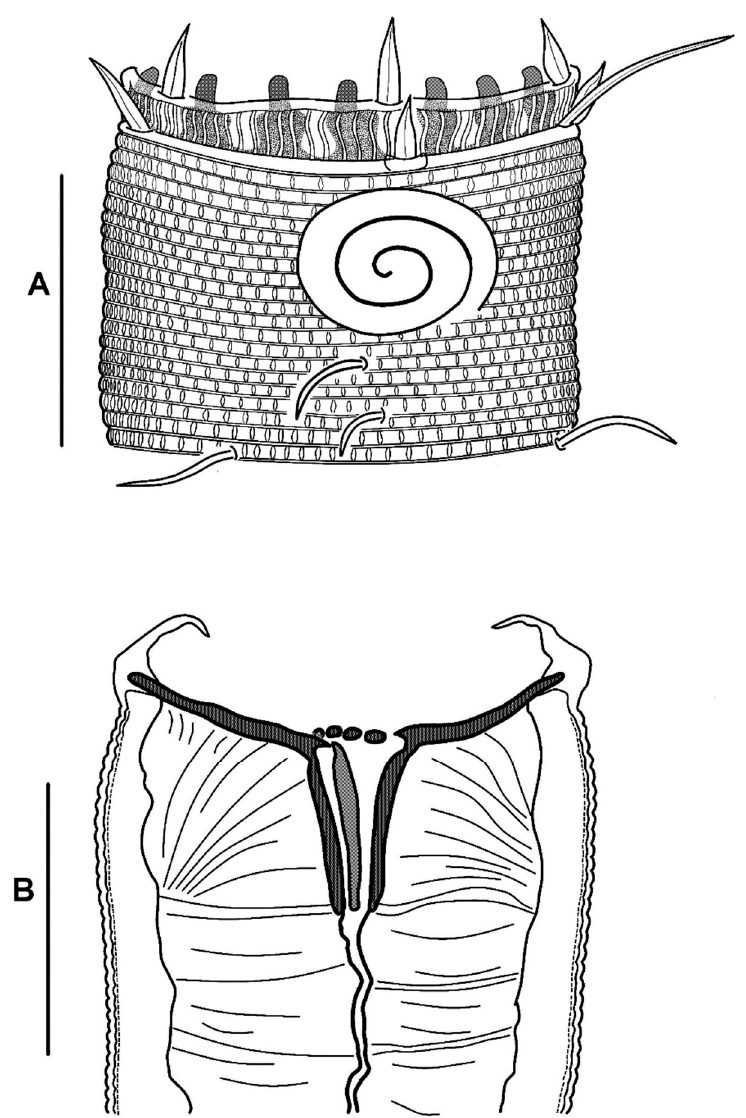
Figure 5. Gammanema okhlopkovi sp. n., head of the holotype male: ( A ) surface view; ( B ) optical section. Scale bars: 20 μ